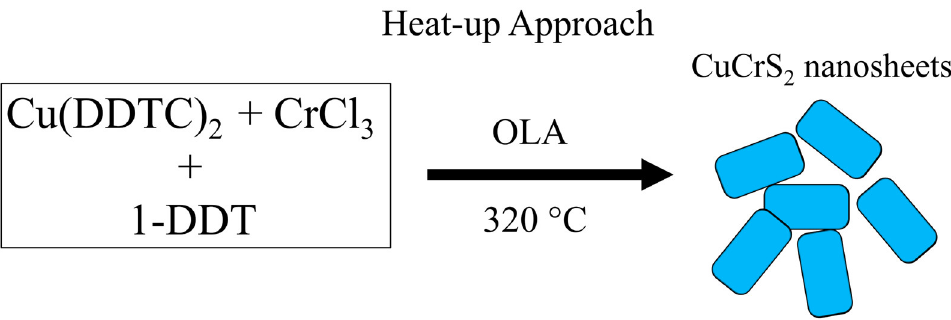
Figure 3. Schematic representation of the heat-up synthesis scheme to obtain CuCrS 2 nanosheets.